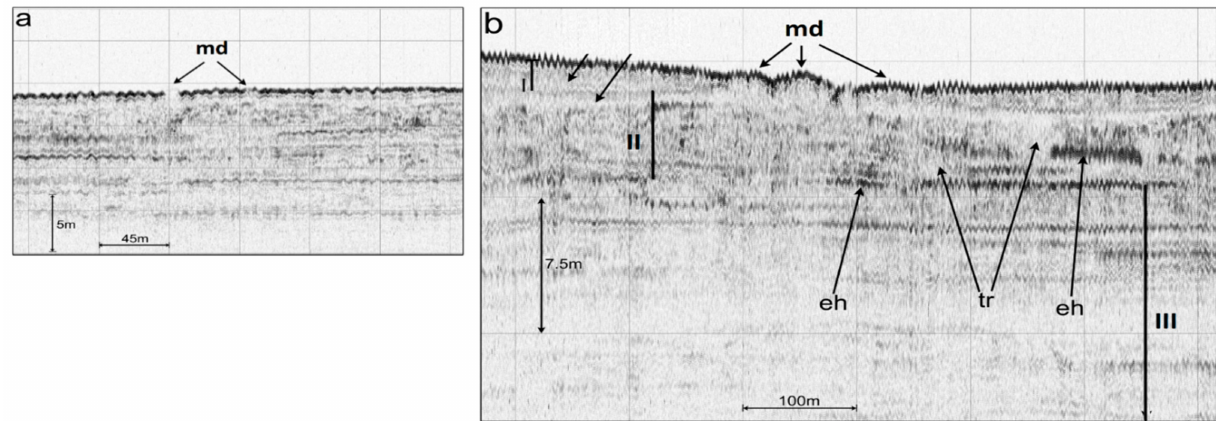
Figure 6. Seismic reflection profiles at 3.5 kHz collected from the areas of mound clusters showing ( a ) examples of small mounds (coralligene algae reefs, md) over the soft seabed and ( b ) specific acoustic characteristics of the upper (I), middle (II) and lower (II) sequence. The middle (II) sequence has a complex internal geometry consisting of discontinuous and locally enhanced (eh) reflectors which are interrupted by areas of acoustically transparent facies